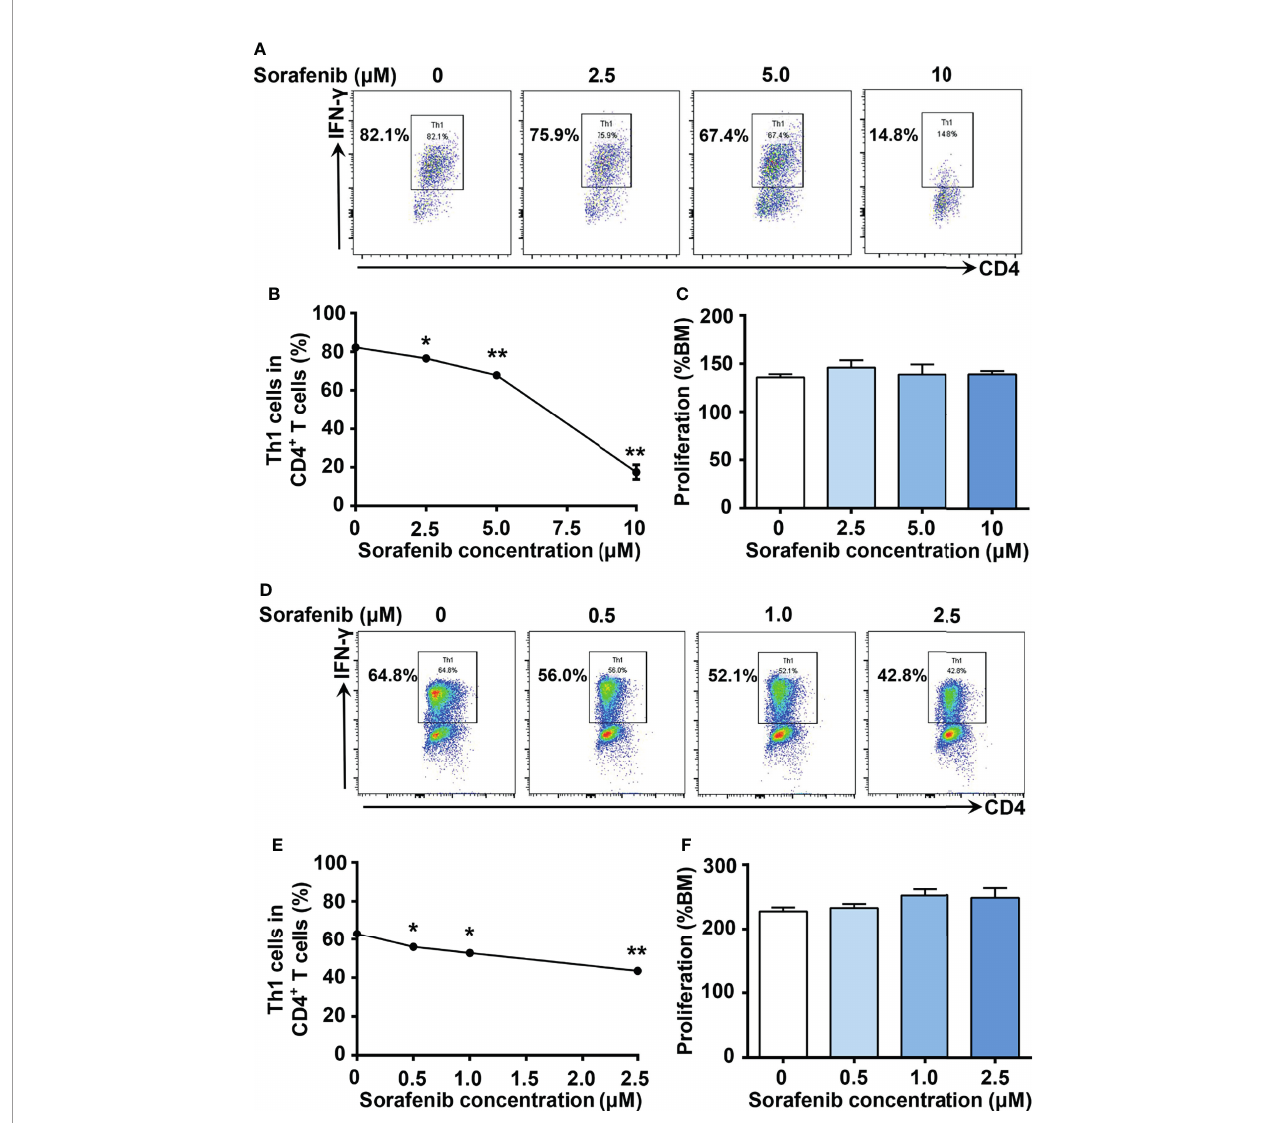
FIGURE 1 | Sorafenib inhibits IL-12-induced Th1 cell differentiation in a dose-dependent manner in both mice and humans. (A, B) Flow cytometry analysis of Th1 cells in mouse naïve splenic CD4 + T cells stimulated with IL-12 in medium containing different concentrations of sorafenib as indicated. (C) CellTiter-Lumi assay to assess viable cells in the naïve splenic Th0 cells cultured in medium containing different concentrations of sorafenib as indicated. (D, E) Flow cytometry analysis of Th1 cells in human naïve PBMC CD4 + T cells stimulated with IL-12 in medium containing different concentrations of sorafenib as indicated. (F) CellTiter-Lumi assay to assess viable cells in the naïve PBMC Th0 cells cultured in medium containing different concentrations of sorafenib as indicated. BM, blank medium. Data are representative of 3 independent experiments. Data represent means ± s.e.m; * P < 0.05 or ** P < 0.01 versus 0 m M by